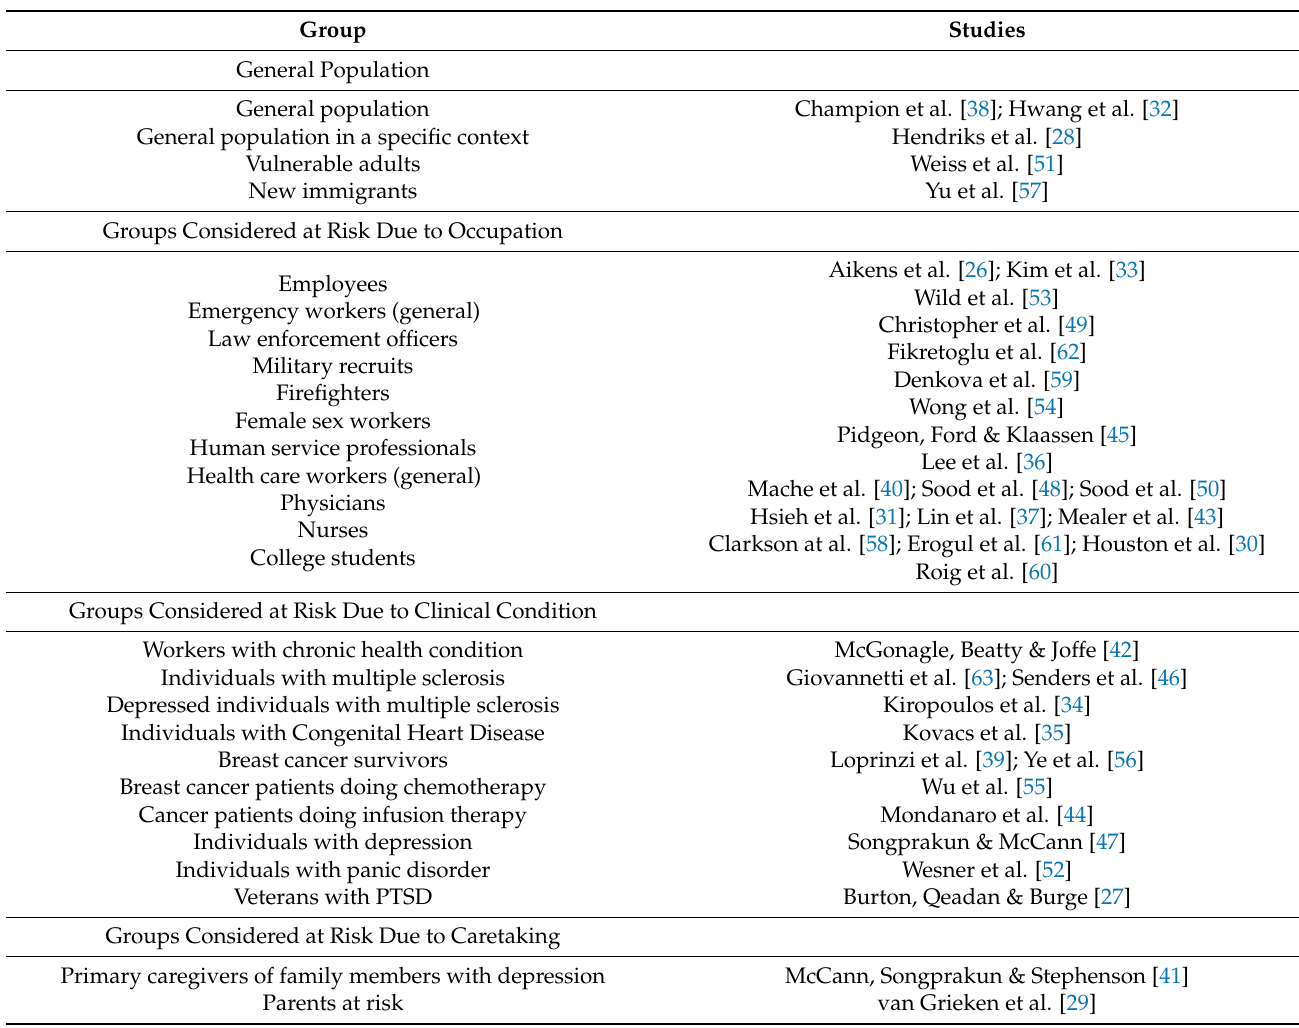
Table 1. Study population